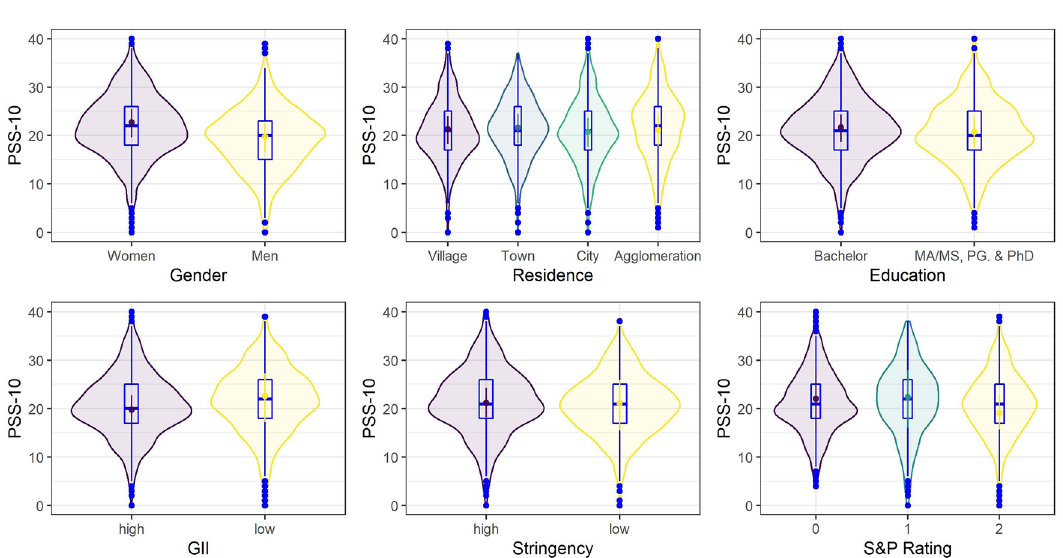
Figure 4. Posterior means of predicted marginal means (points) with 95% credible intervals (vertical lines) from the Bayesian skew-normal multilevel model for perceived stress (PSS-10) scores. Boxplots and violin plots show the distribution of the